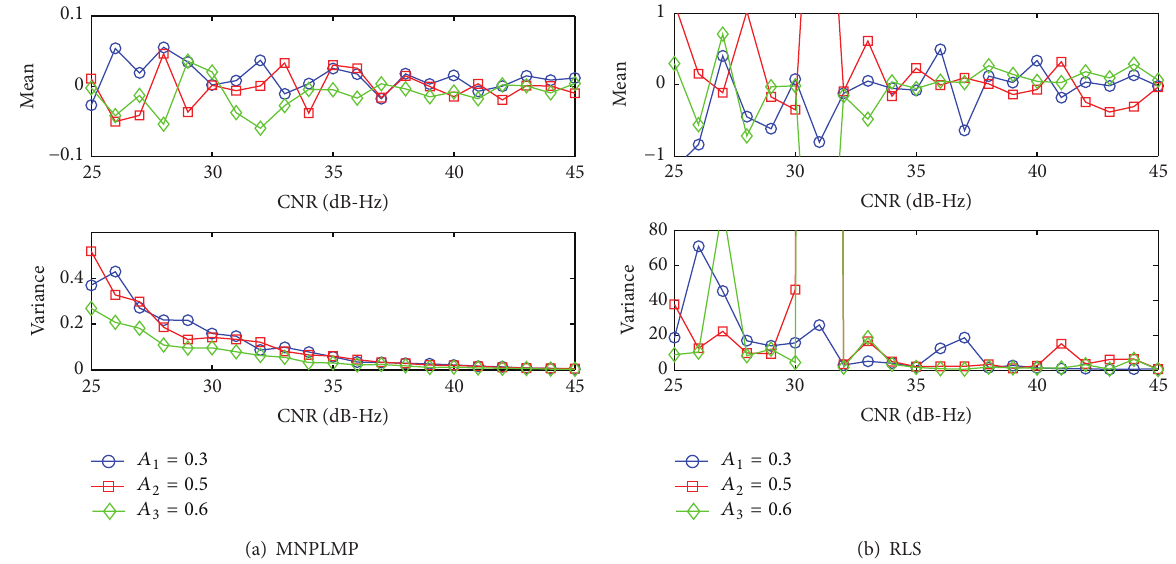
Figure 11: Multipath amplitude estimation errors in various CNRs under an impulsive noise environment.